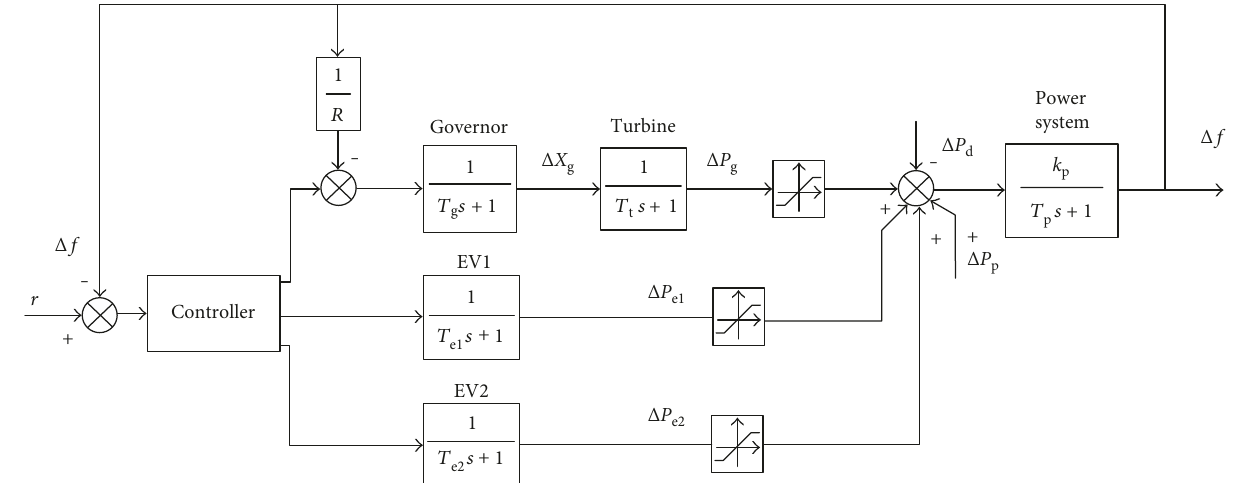
Figure 1: The schematic diagram of the benchmark